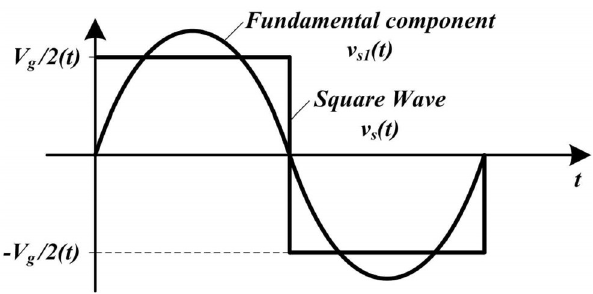
Figure 3. Output voltage of switch network along with its fundamental component.